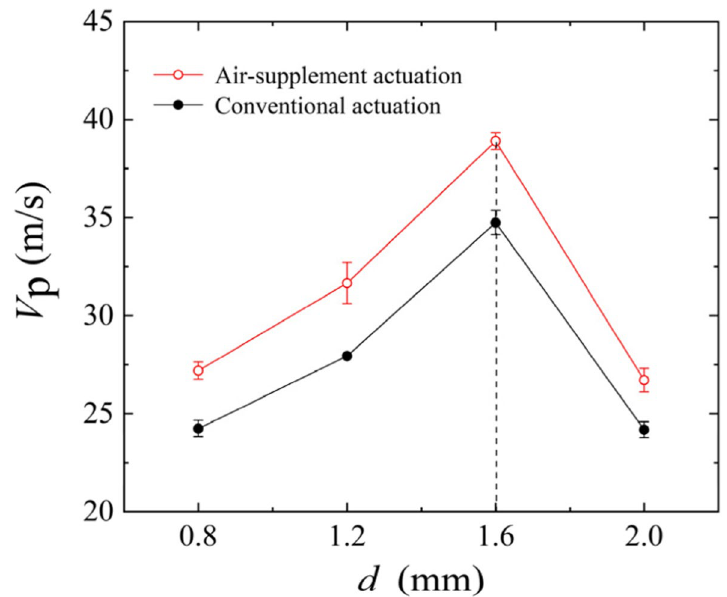
Fig. 12 Air‑supplement PSJ velocities according to jet orifice